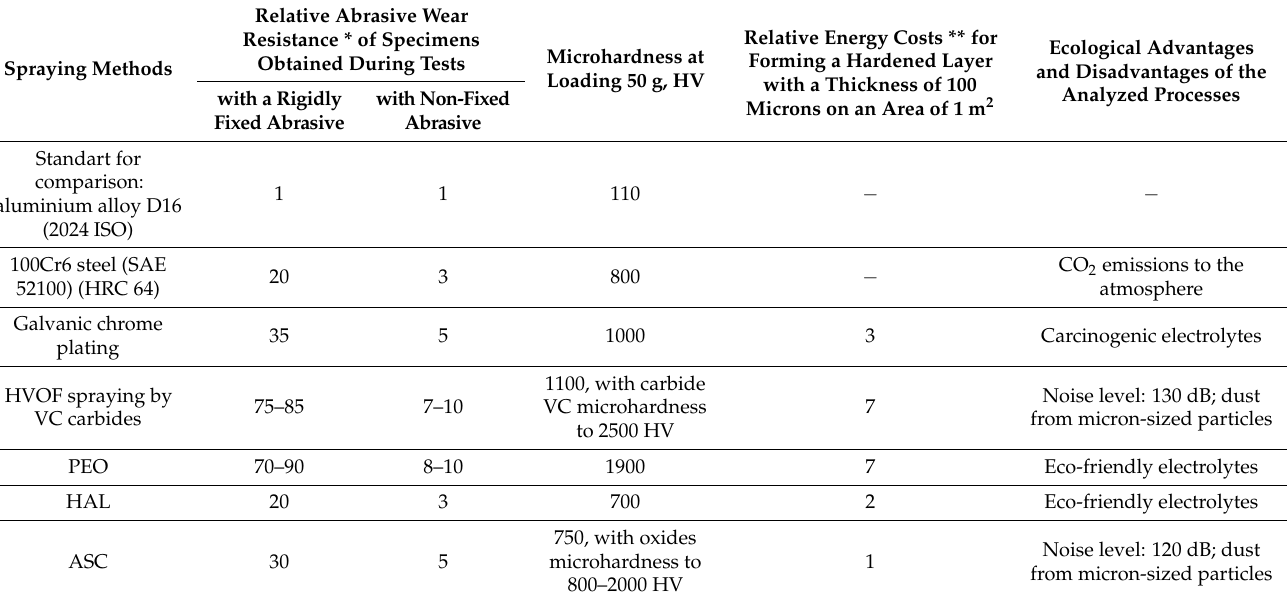
Table 1. Ranking of the surface layers of aluminum alloys, hardened in different ways, according to the properties that determine their functional